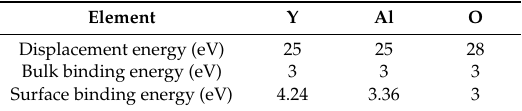
Table 2. The displacement energies, the bulk binding energies, and the surface binding energies of Y, Al, and O atoms in YAG crystal, used for the SRIM 2013